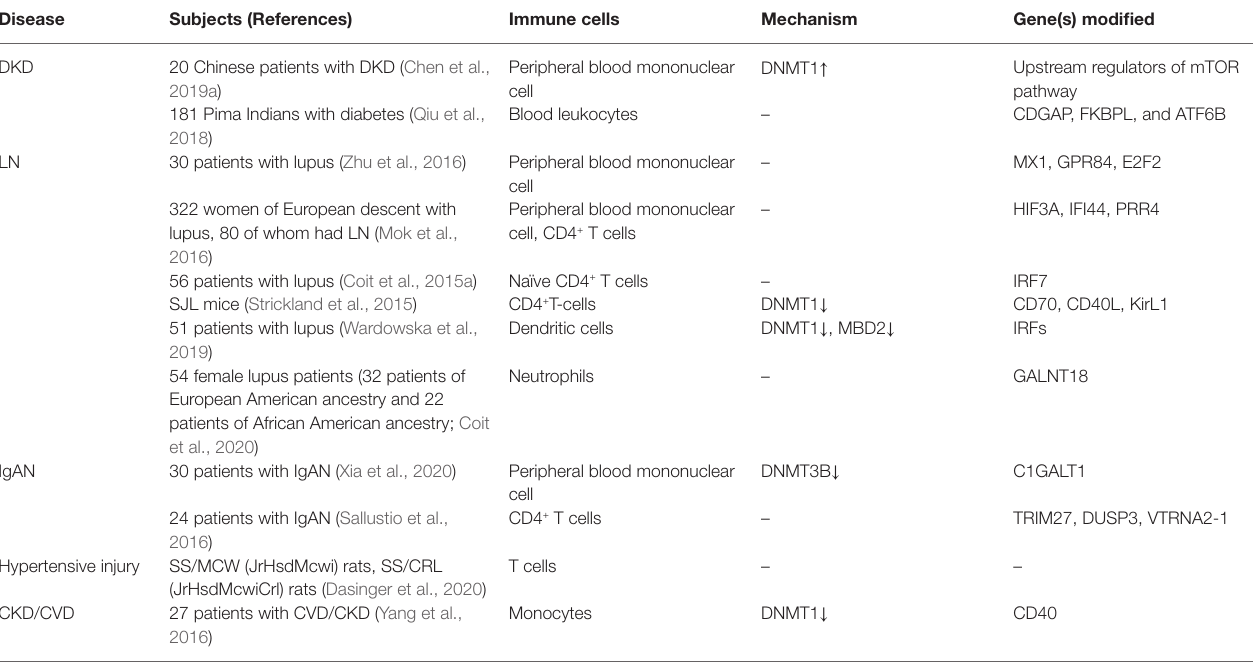
TABLE 1 | Summary of main changes in DNA methylation in CKD development with immune cells.